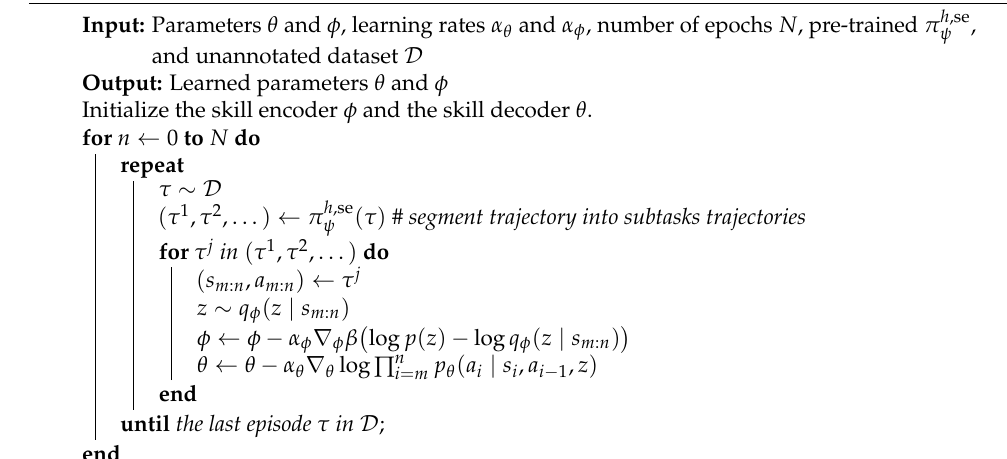
Algorithm 1: Latent Skill Space Learning